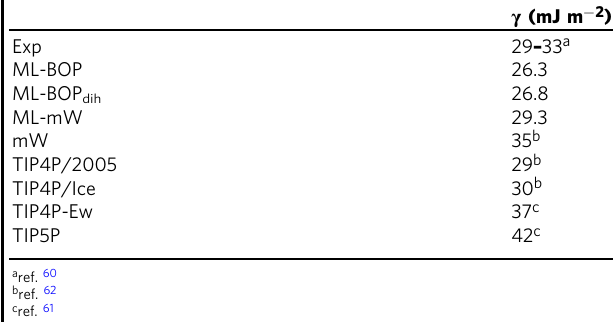
Table 4 Solid-liquid interfacial energies for hexagonal ice